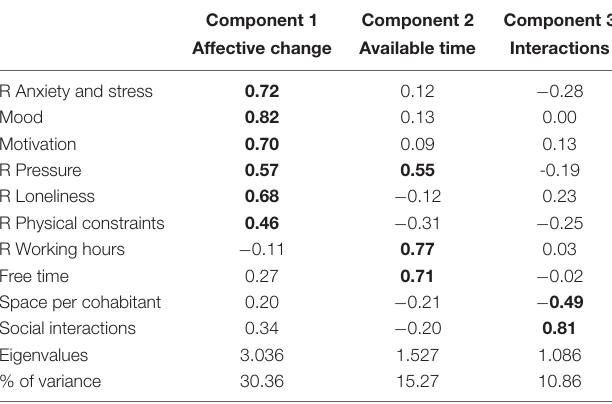
TABLE 2 | Summary of exploratory principal component analysis results for the variables hypothetically related to creativity changes during the lockdown period ( n =